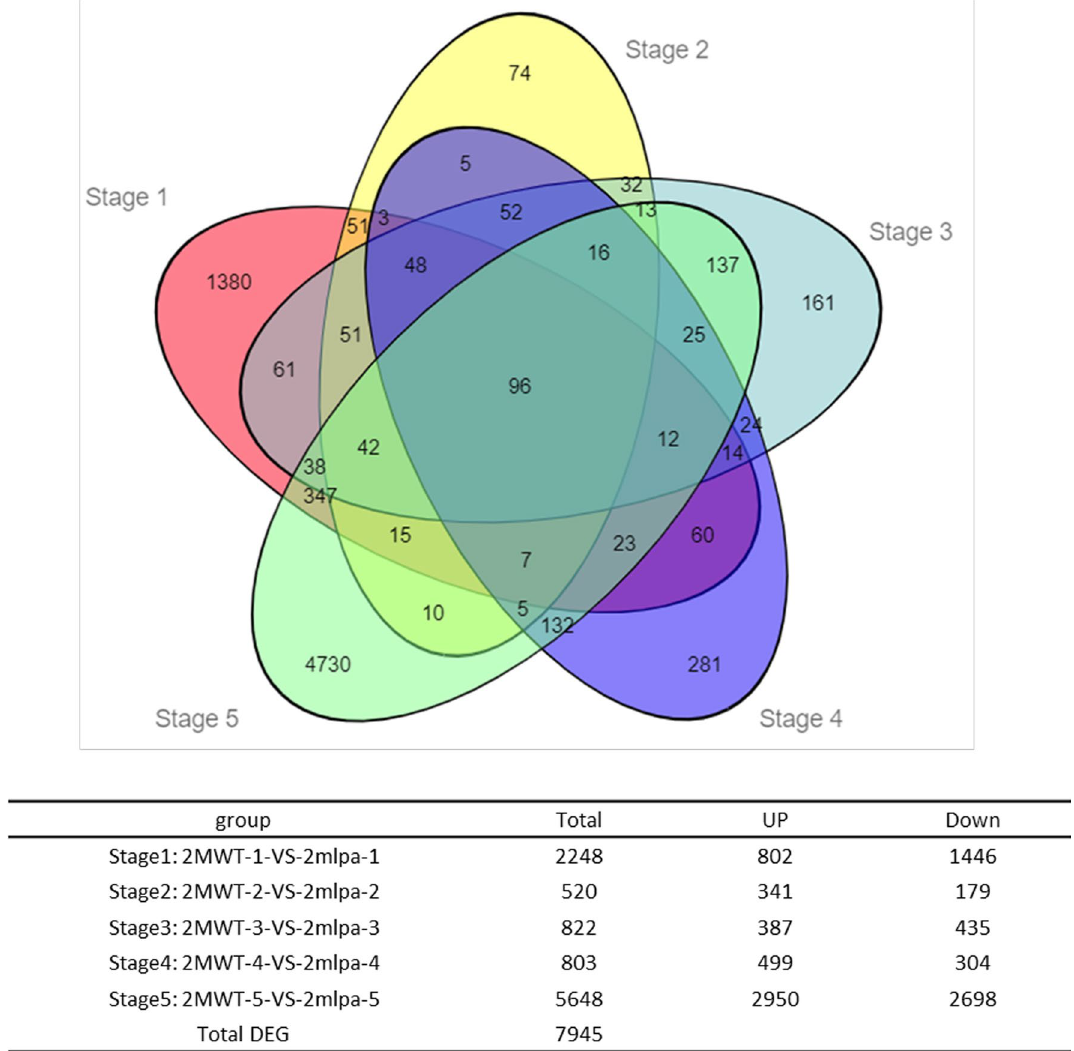
Figure 2. Venn diagram of the co-expressed and uniquely expressed DEGs between 2mlpa and 2MWT in five seed developmental stages. The number of DEGs between 2mlpa and 2MWT in each stage is also